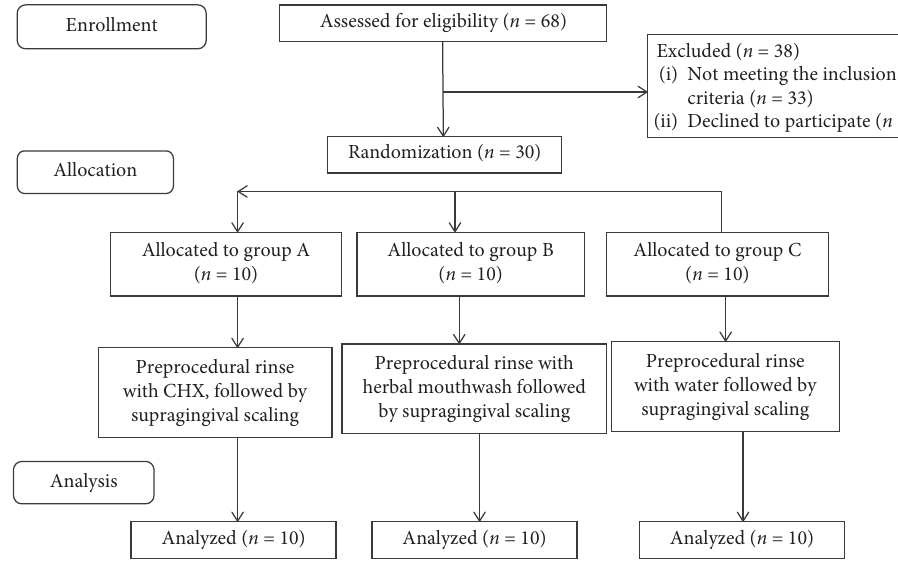
Figure 1: Patient flow diagram. Table 1: Demographic and clinical parameters among the three